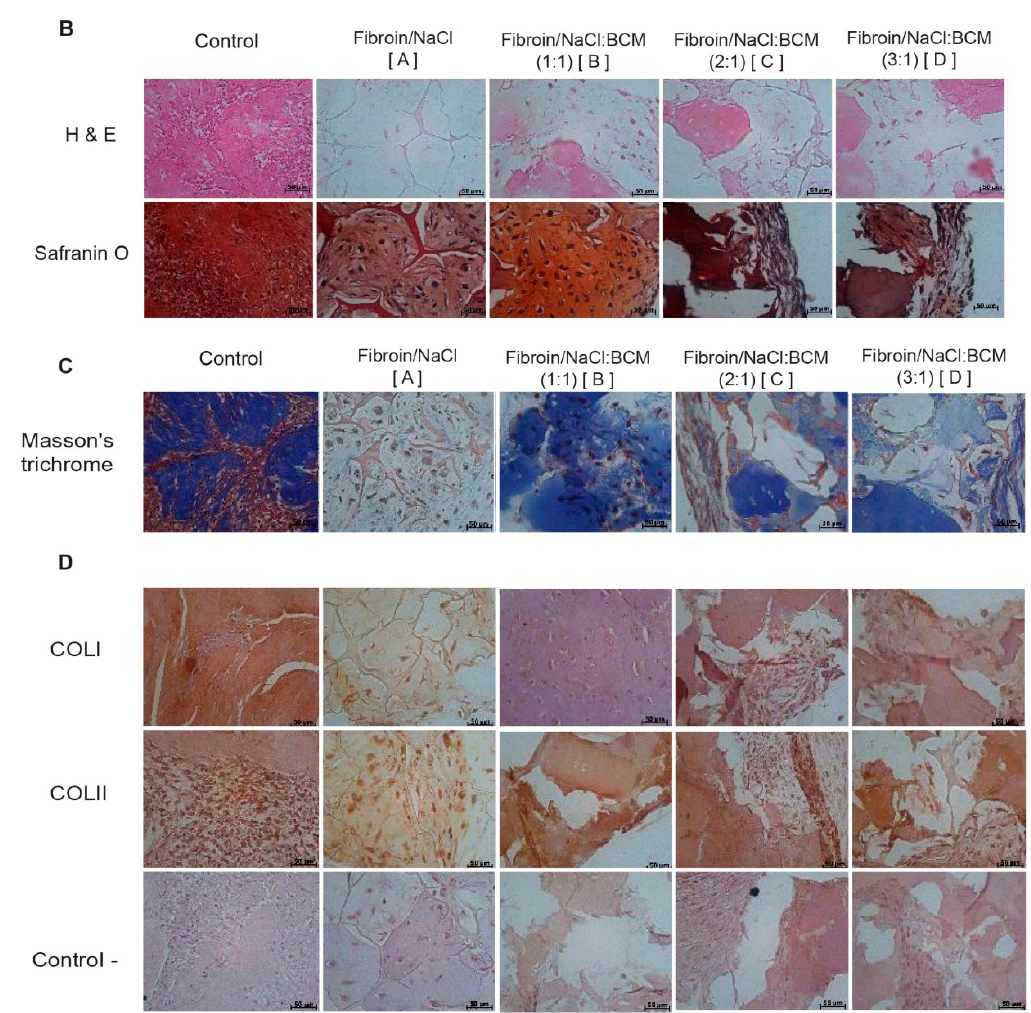
Figure 5. In vitro response of chondrocytes in biofunctionalized biphasic sca ff olds. ( A ) Relative gene expression of SOX9, ACAN COL2A1, COLXA1 and MMP13 . The data are reported as the mean ± standard deviation ( n = 3). * p < 0.05, ** p < 0.01, *** p < 0.001 versus MC. NI = Non-induced control, MC = Monolayer culture. Histological evaluation of Groups A to D after 28 days of culture. ( B ) Hematoxylin and eosin (H&E), and safranin O staining showing that the group consisting of fibroin / NaCl:BCM in a ratio of 1:1 showed a structural organization of the neoformed tissue similar to the native chondral tissue. ( C ) Masson’s trichrome staining showed, in the same Group B, a strong positive staining of hyaline cartilage with a good column alignment of chondrocytes, which was similar to the morphology of native cartilage. ( D ) Representative images for type II and type I collagen immunohistochemistry. All the groups showed weak positive staining for type I collagen, as well as a strong signal for type II collagen. Negative controls were treated with PBS without primary antibodies. Scale bar = 50 µ